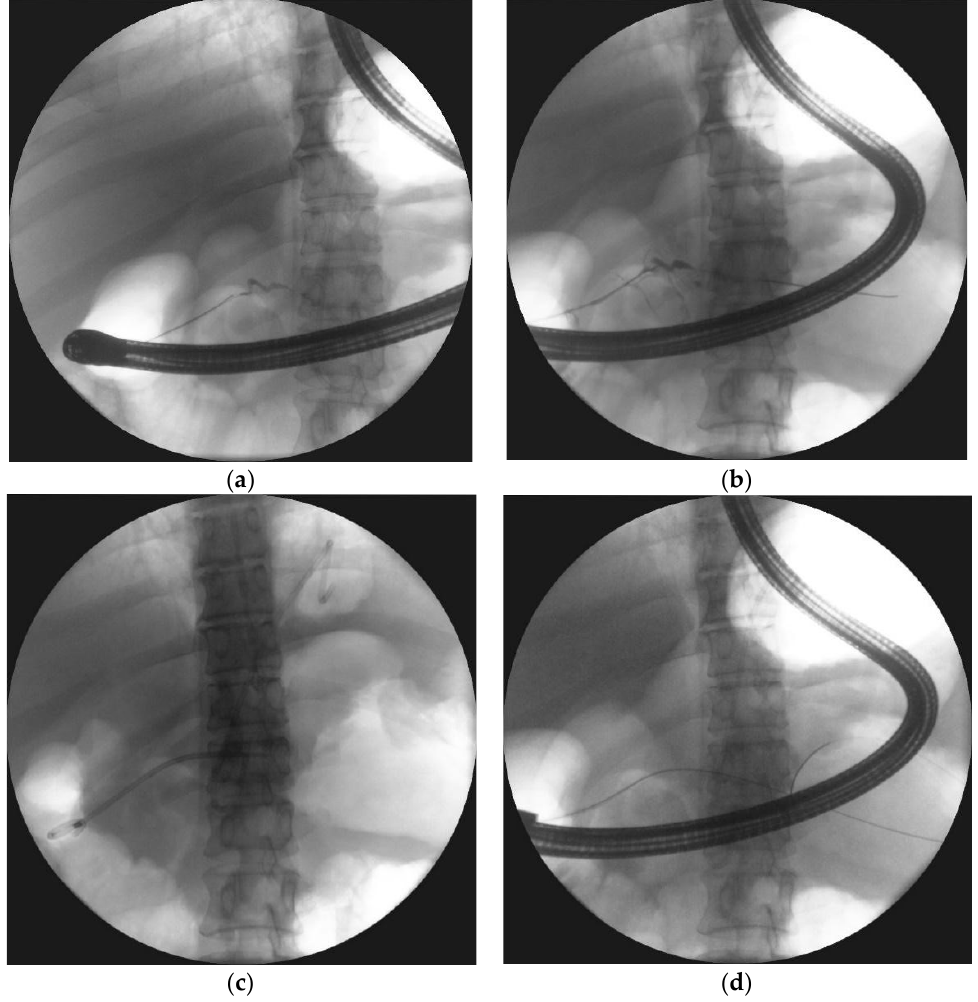
Figure 11. ERP was performed during endoscopic treatment for pancreatic necrosis. ( a ) Contrast dye is spilling out through the complete pancreatic duct disruption at the isthmus. ( b , c ) The guide wire was introduced through the complete pancreatic duct disruption and looped within the necrotic collection. ( d ) The stent was inserted through the duodenal papilla (red arrow) with the distal end within the collection, where the transmural stent is also visible ERP, endoscopic retrograde pancreatography.